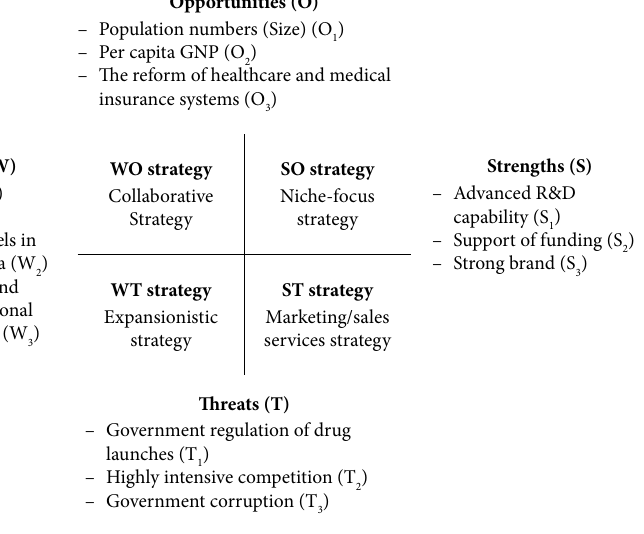
Fig. 1. The grand strategy matrix based on SWOT